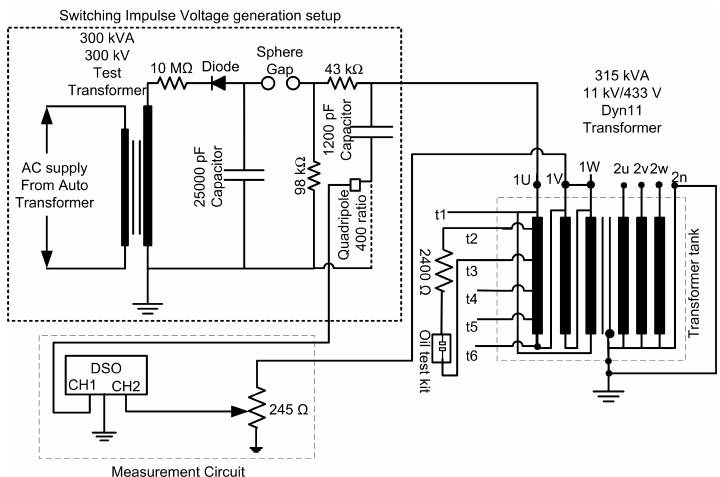
Figure 3. Circuit for the diagnosis of the source of PD across the minor.